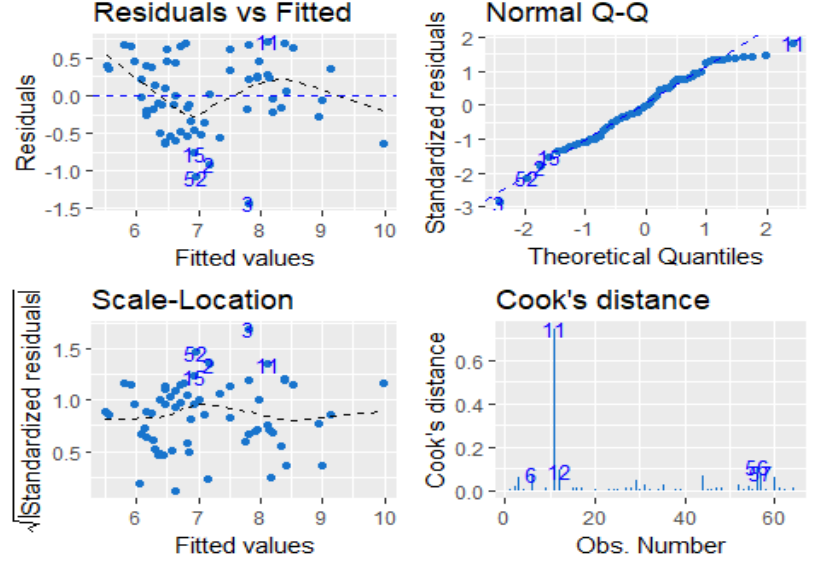
Fig. 8. Diagnostic plots (log-log OLS model)